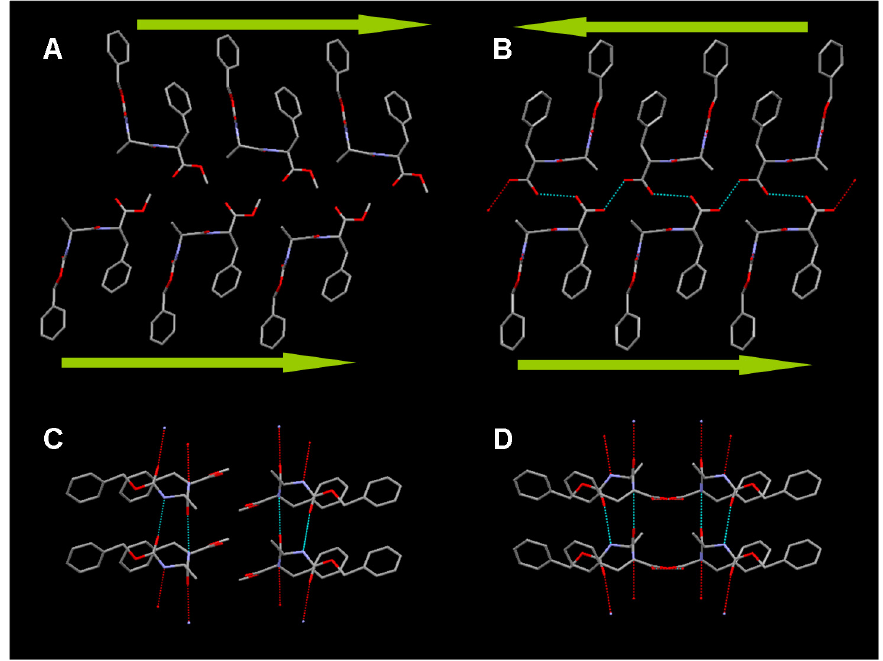
Figure 5. Intermolecular contacts found in the solid state for Z-AF-OMe (A,C) and Z-AF- OH (B, D). H atoms have been omitted for clarity and H bonds are shown as dashed